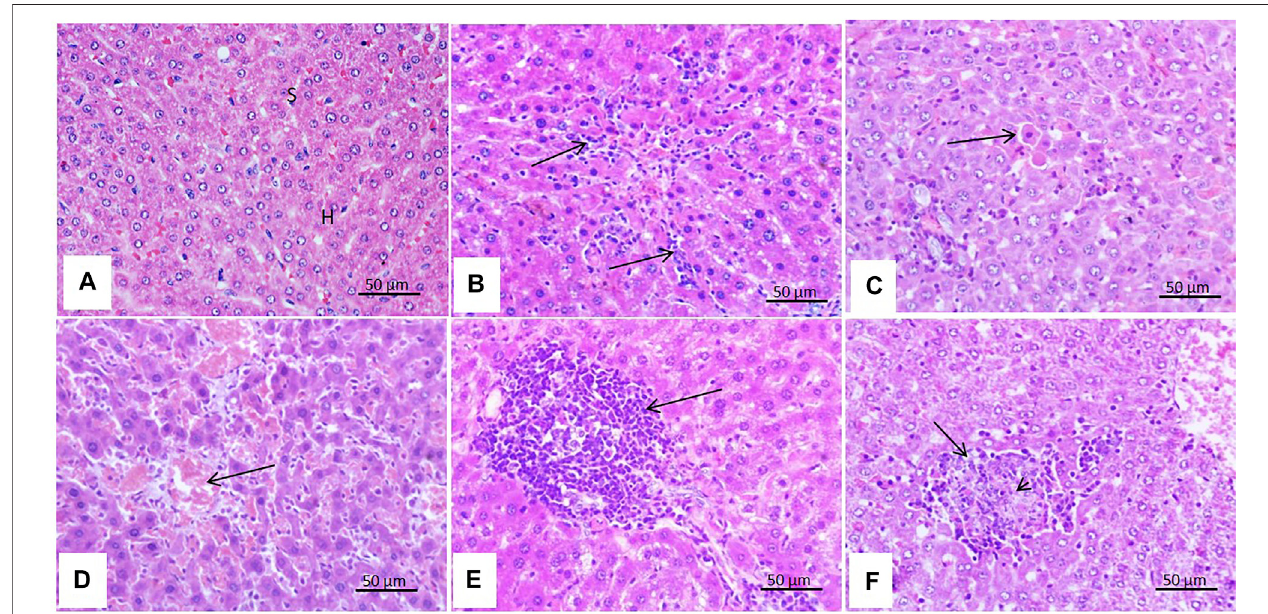
FIGURE 3 | Effect of malathion on the liver. (A) Liver of the control rats showing intact hepatic parenchyma with normal arrangement of hepatocytes (H), sinusoids (S), and central vein (C). (B) Liver of rats treated with malathion for 24 h showing mild sinusoidal cell activation (arrow) and (C) single cell necrosis of hepatocytes (arrow). (D) Liver of rats treated with malathion for 21 days showing severe congestion (arrow), (E) massive periportal mononuclear cell in fi ltration (arrow), and (F) focal hepatocytic necrosis (arrow) with the in fi ltration of mononuclear cells within and at the margin of the necrosis areas (arrow head).